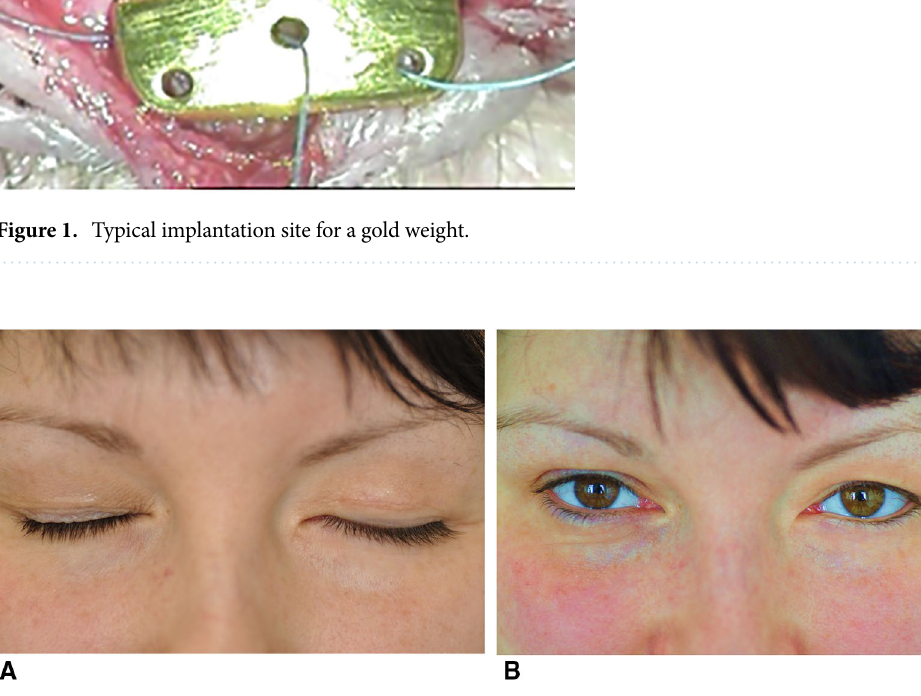
Figure 2. Optimal result in 37 year old patient after upper eyelid gold weight loading in left eye at a 6 month follow-up. ( a ) Patient at a 6-month follow-up after loading of the left upper eyelid with a gold weight (1.4 g) with closed eyes. ( b ) Patient at a 6 month follow-up after loading of the left upper eyelid with the gold weight (1.4 g) in primary